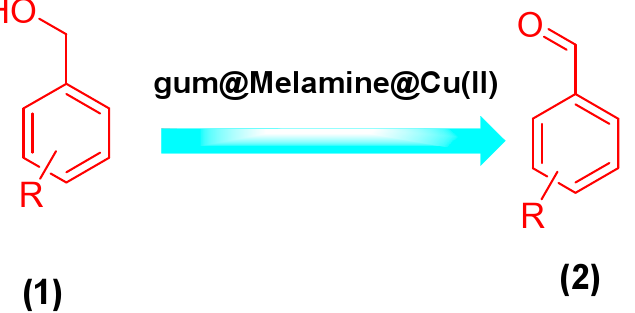
Scheme 1. Synthesized derivatives in an oxidation reaction.